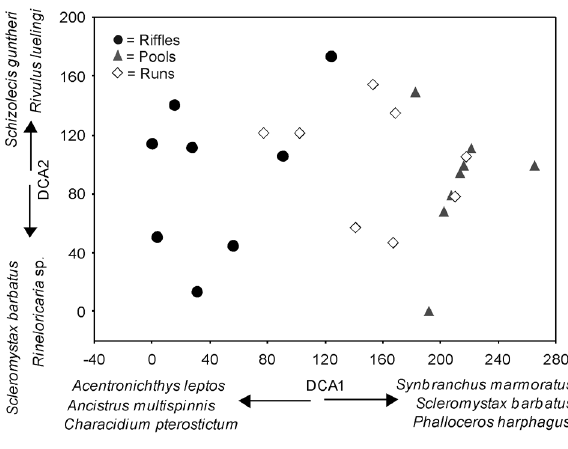
Figure 6. Ordination of sampling mesohabitats in the middle reach through a detrended correspondence analysis (DCA) applied to den- sity matrix of fish species in the Vermelho River, Paraná state, Brazil.